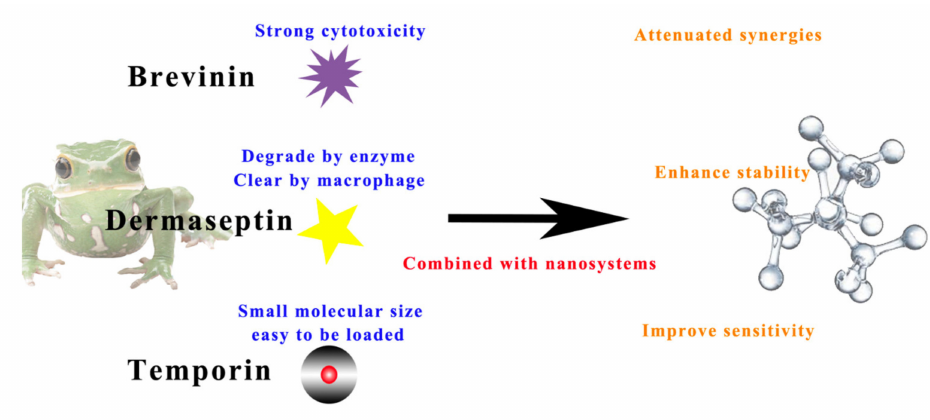
Figure 11. Application samples for constructing nanodelivery systems with